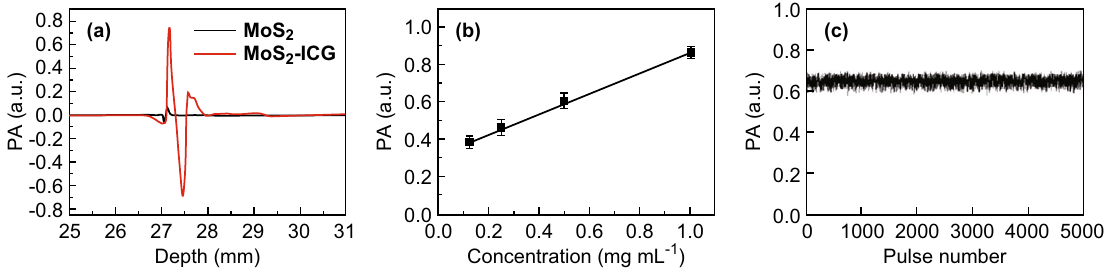
Fig. 2 a Photoacoustic (PA) signal comparison of MoS 2 and MoS 2 –ICG at the same concentration of MoS 2 . Photoacoustic signals of b MoS 2 – ICG at different concentrations and c MoS 2 –ICG illuminated with 5000 laser pulses